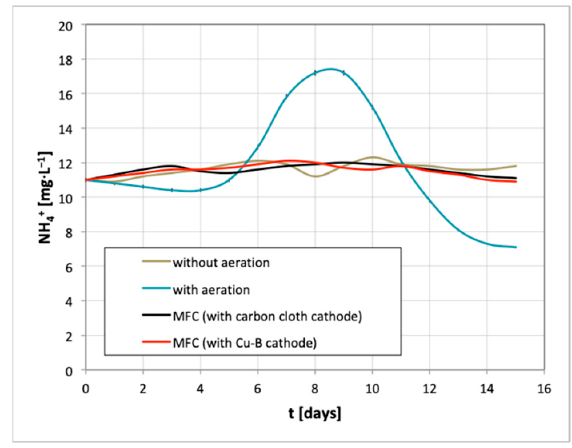
Figure 11. Trend of NH 4+ reduction during wastewater treatment performed at the different reactors.